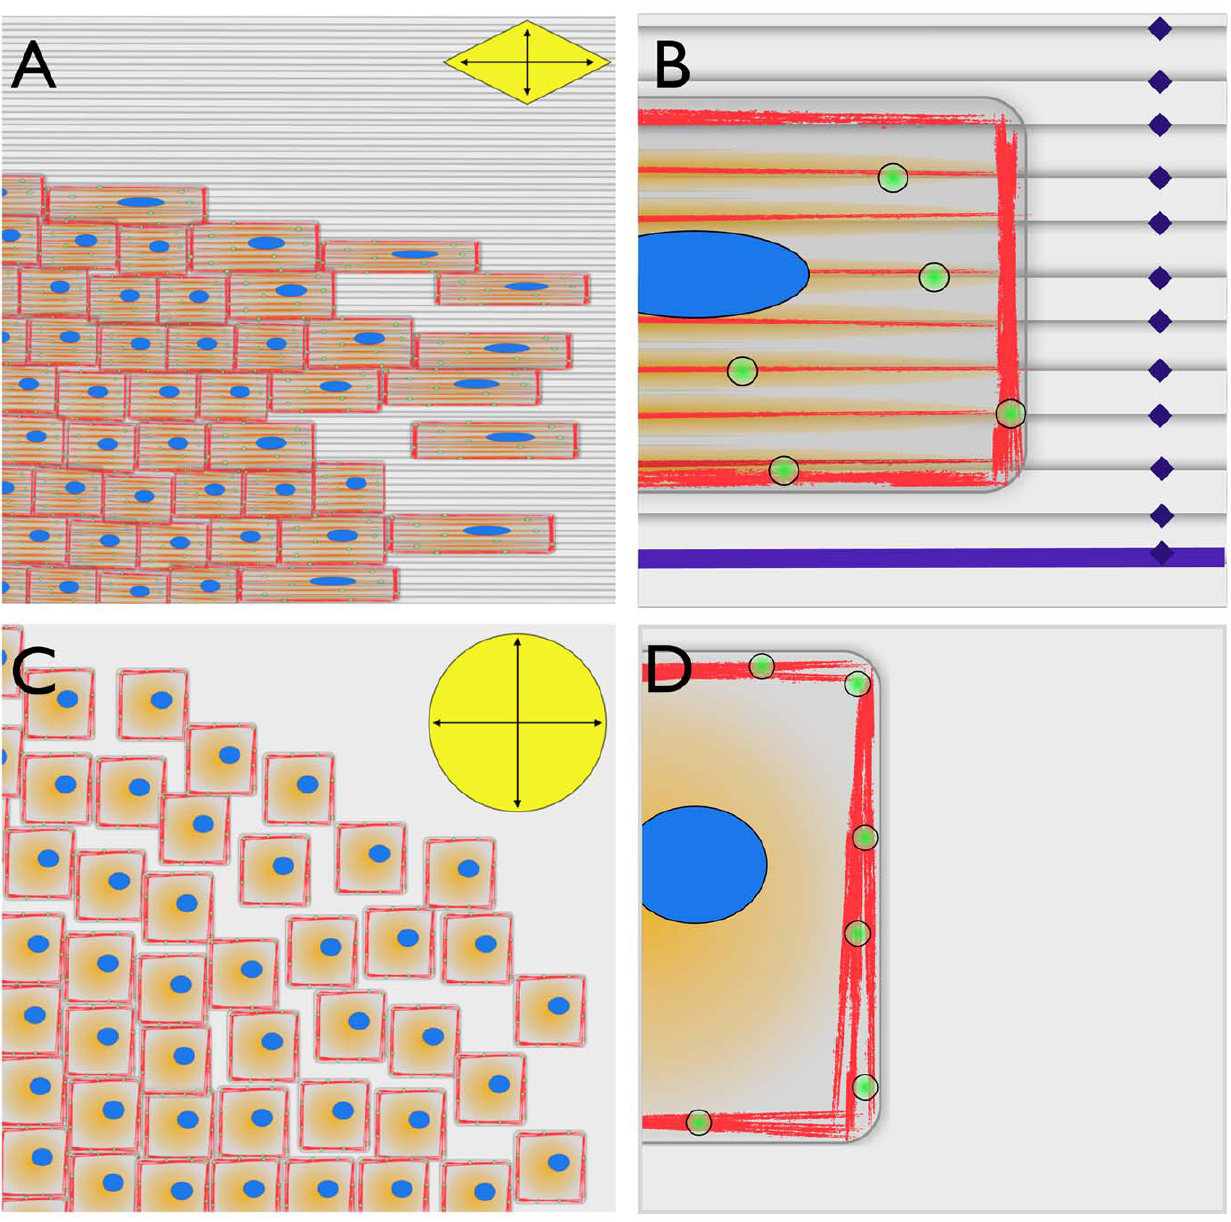
Figure 8. Schematic representations of cell sheet migration. Representative renditions of cell sheet migration on (A-B) patterned and (C-D) flat silk film surfaces. (A) Cell sheet migration on patterned silk surfaces was compact in nature with leading border cells elongating in the parallel direction of the patterned feature edge. Migration rate was 2-fold higher in the parallel direction of the feature edge when compared to perpendicular movement direction as indicated by the vectors contained in yellow diamond. (B) Actin fibril (red), FA (green), and GTPase (orange) proteins were found to preferentially localize along the surface feature edges as indicated in purple coloring. (C) In contrast, cell sheet migration on flat silk film substrates was less compact with leading cells maintain a normal cuboidal morphology. Migration rate was similar in all directions as indicated by the vectors contained in the yellow circle. (D) Actin fibrils (red) and FAs (green) were found to primarily localize at the cellular basal periphery region with GTPase proteins (orange) localizing uniformly within the central region of the